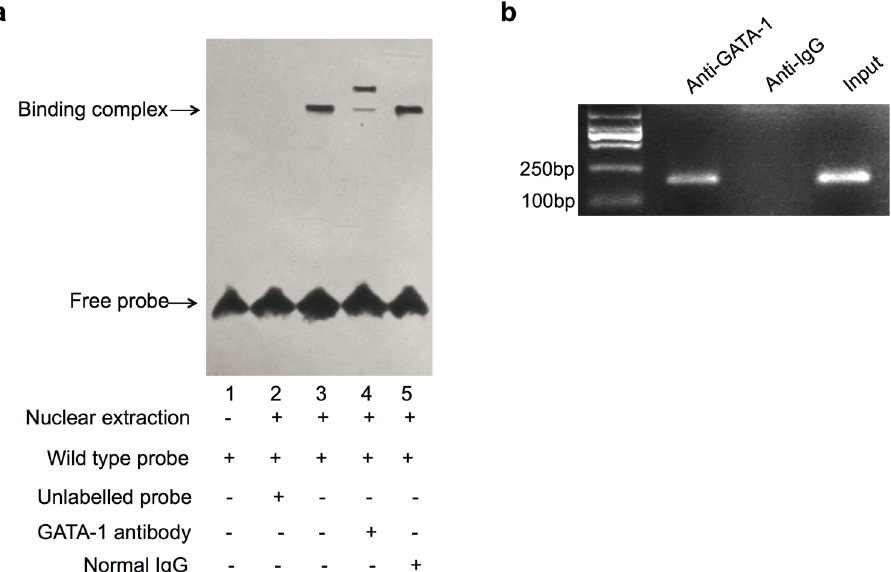
Figure 2. The interaction of GATA-1 and IRF-3 promoter in vitro and in vivo . ( a ) EMSA was performed with a DNA probe harboring the GATA-1 element ( − 82 to − 75) on the IRF-3 promoter as described in the methods section. ( b ) A549 cell lysate was subjected to ChIP assay using anti-GATA-1 (IP: GATA-1) or non-specific IgG (negative control) antibodies. After purification of DNA, the IRF-3 promoter area ( − 149 to + 18) was amplified by semi-quantitative PCR. The full-length gel was presented in Supplementary Figure